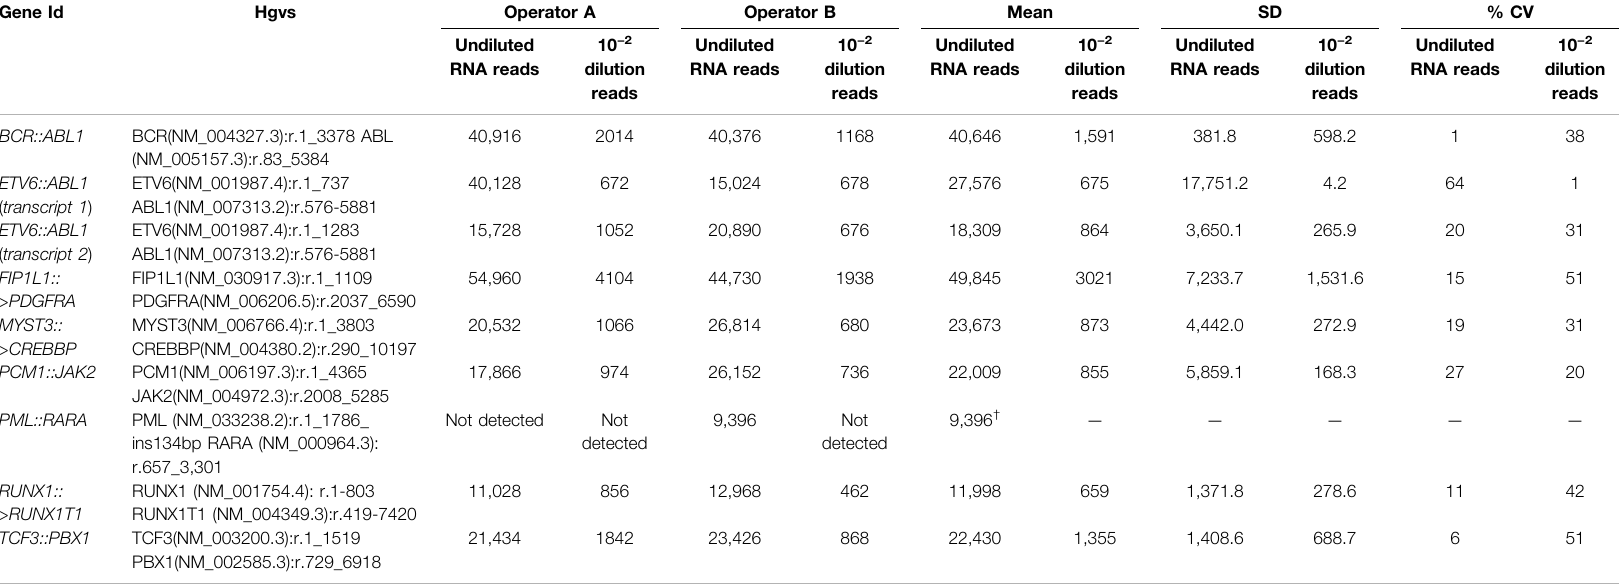
TABLE 2 | Obtained reads, mean SD, and %CV for undiluted RNA and 10 – 2 dilution for each of the fusion genes analyzed. Libraries were performed by two operators (A and